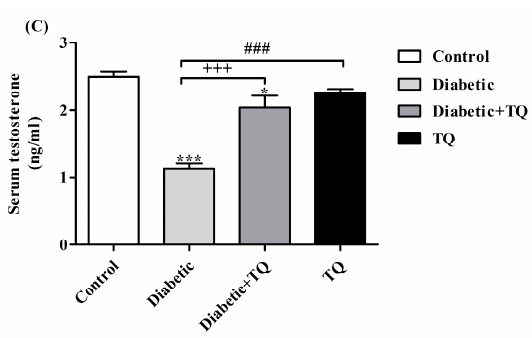
Figure 5. Levels of testicular testosterone ( A ) and estradiol ( B ) and serum testosterone ( C ) in Control, Diabetic, Diabetic + TQ, and TQ groups. * p < 0.05 and *** p < 0.001 vs. Control. ++ p < 0.01, +++ p < 0.001 vs. Diabetic. ## p < 0.01, and ### p < 0.001 vs. TQ. TQ; thymoquinone.